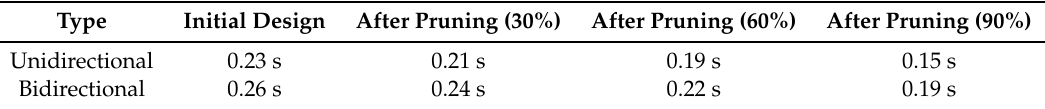
Table 4. Execution Time of Pruning Networks.